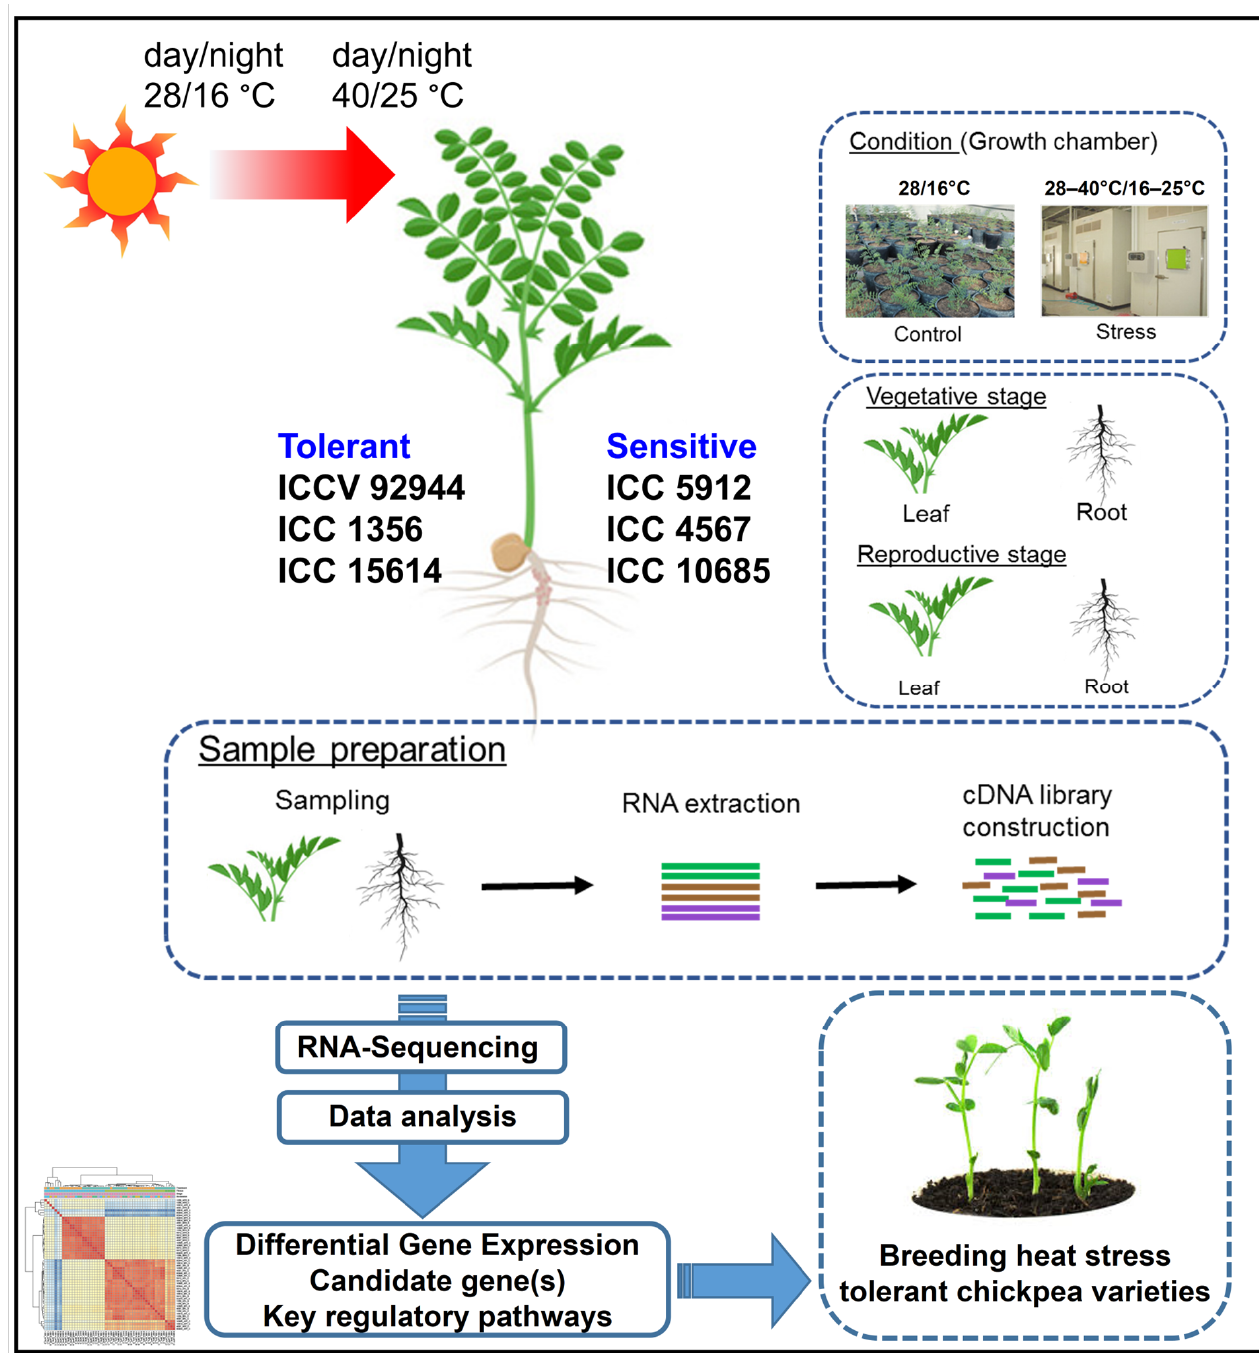
Figure 1. Graphical representation of the experimental design and transcriptome analysis for iden- tifying key genes and molecular mechanisms associated with heat tolerance in chickpea. This figure provides an overview of the experimental conditions, samples/developmental stages targeted, RNA-seq analysis performed, results obtained, and future prospects of the present study. The reads (440.51 million) mapped on the chickpea genome were used to generate reference-guided assembly and to analyze global and differential gene expression pro- files. The reference-guided assembly generated 31,707 genes, and its comparison with the chickpea genome led to the identification of 28,769 annotated and 2938 novel genes. The normalized expression level, fragments per kilobase of exon per million mapped (FPKM) reads of each gene, was estimated in all 48 samples studied. To exclude genes with low confidence expression values, only those genes with an FPKM ≥ 1 in at least one of the samples analyzed were designated as expressed (Supplementary Table S1). Further, hier- archical clustering of Pearson’s correlation in the transcriptome data was performed for the 48 samples studied (Figure 2). Here, leaf samples (before and after flowering) of all six